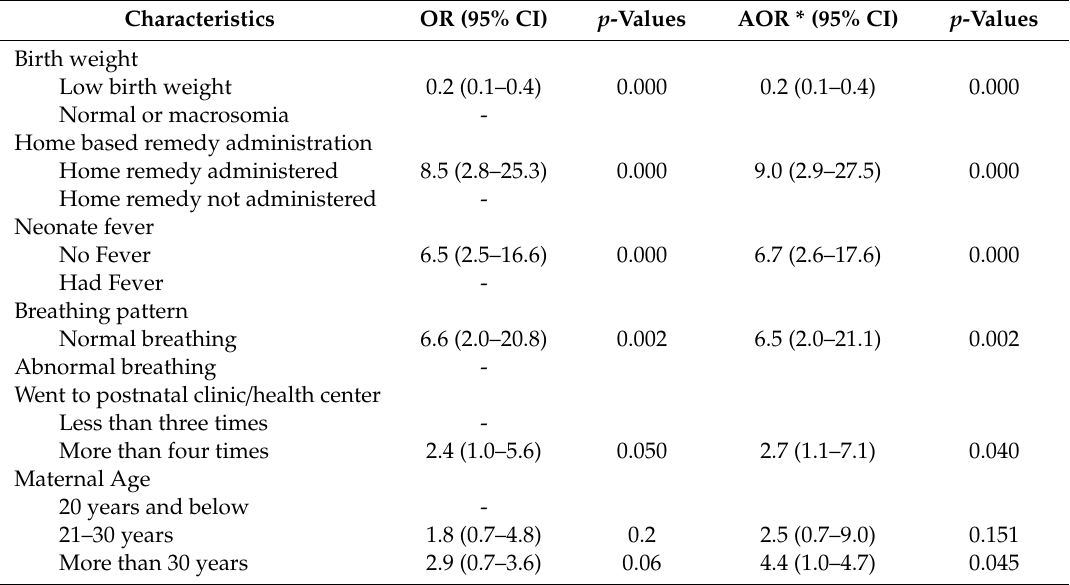
Table 5. Logistic regression of factors independently associated with delay in seeking care at a neonatal